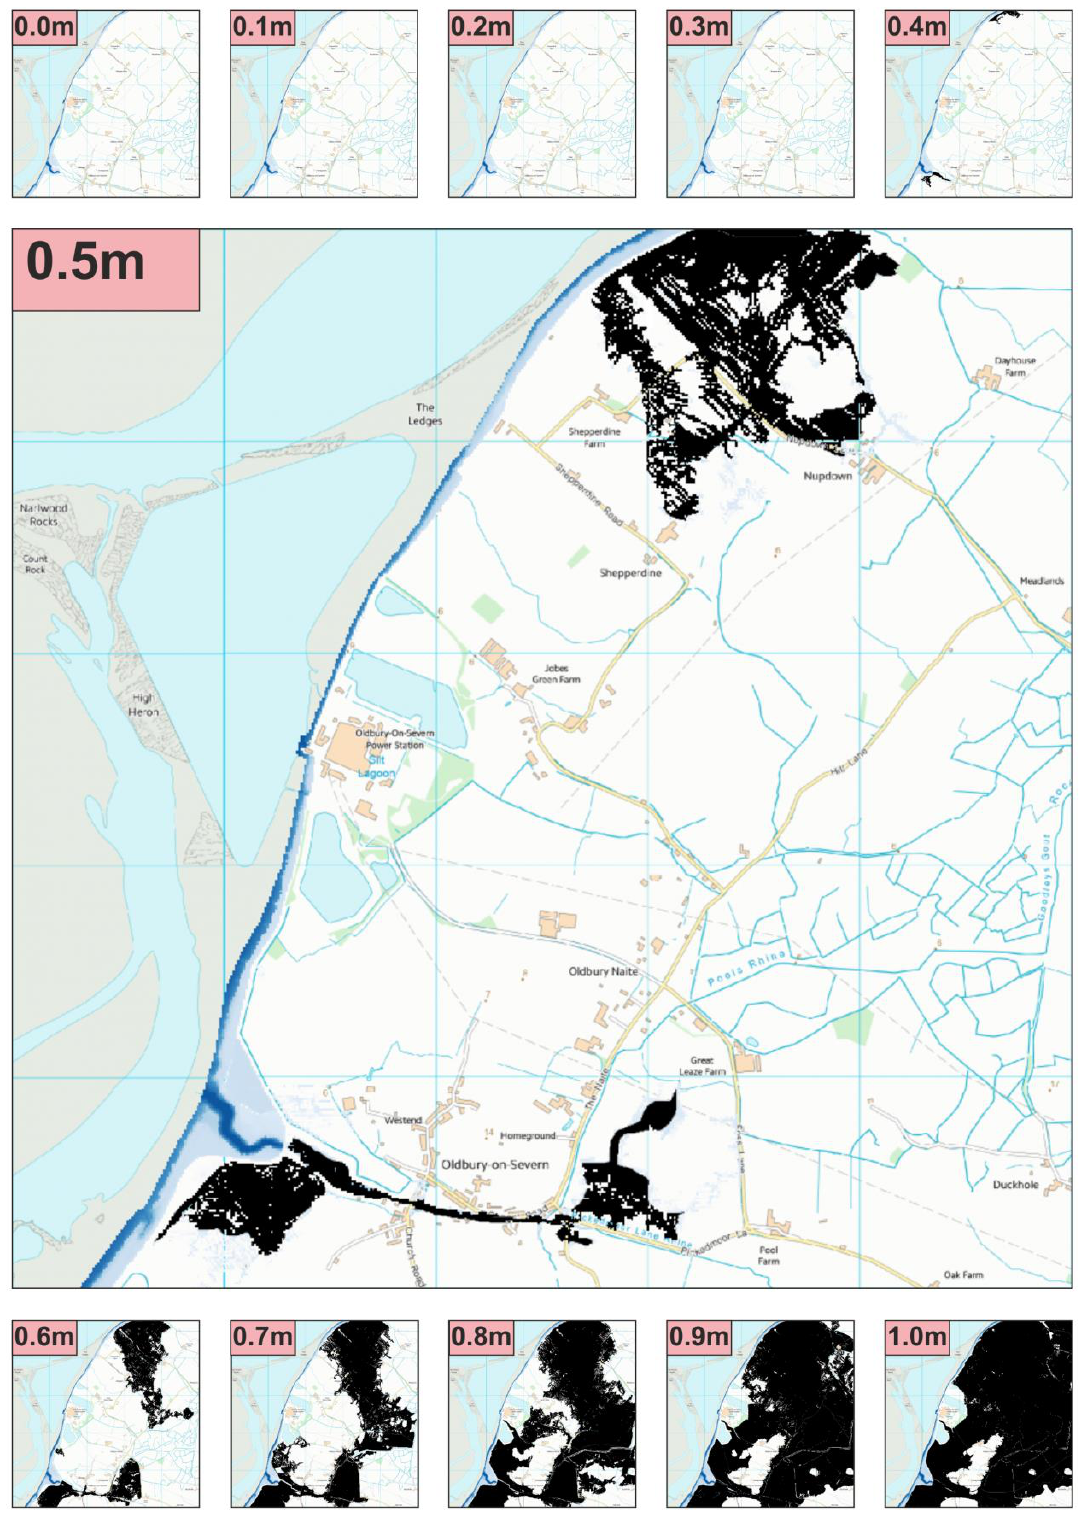
Figure 5. Maps of potential flooding due to a 1-in-5-year extreme water level under 0.0–1.0m sea-level rise in 10cm increments (black areas indicate the flood water extent behind the sea defences). A “tipping point” in the area prone to flooding is seen at 0.50m of sea-level rise, with substantial increases in areal extent